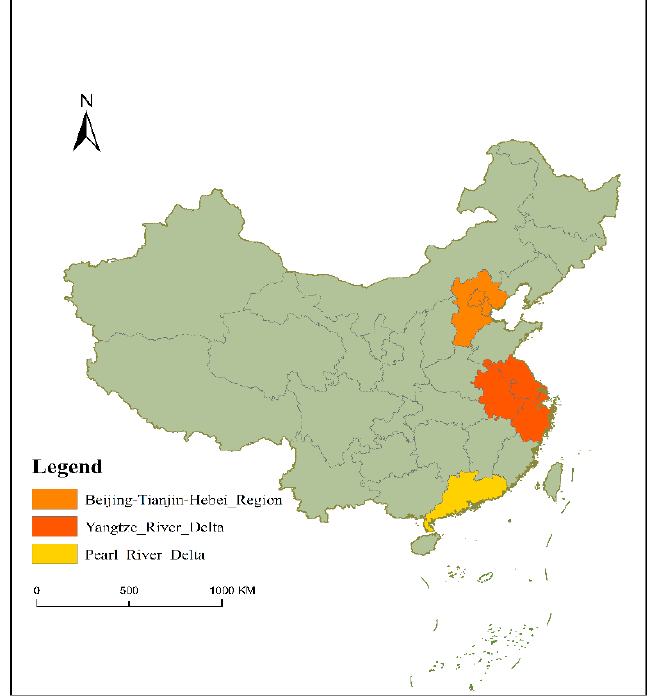
Figure 1. APPA implementation focus areas.